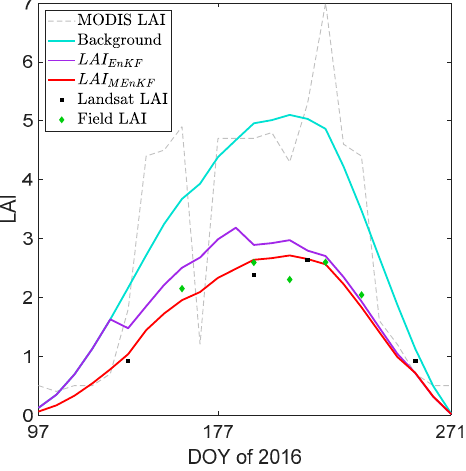
Figure 5. LAI time series generated by MEnKF for grassland.